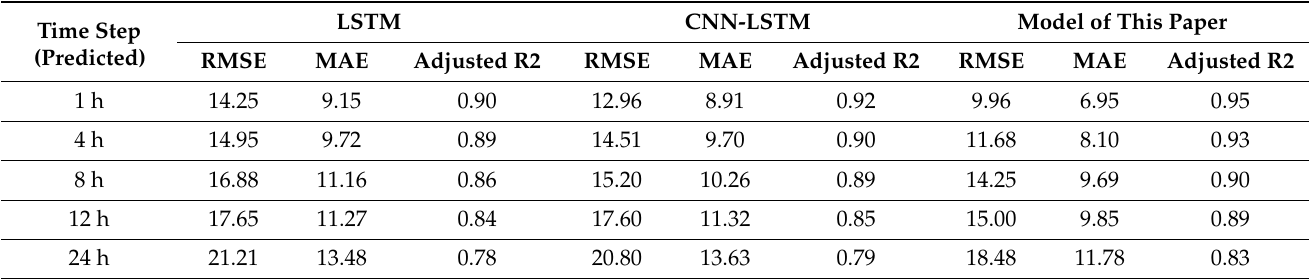
Table 3. Comparison of the performance of the three methods for different time step